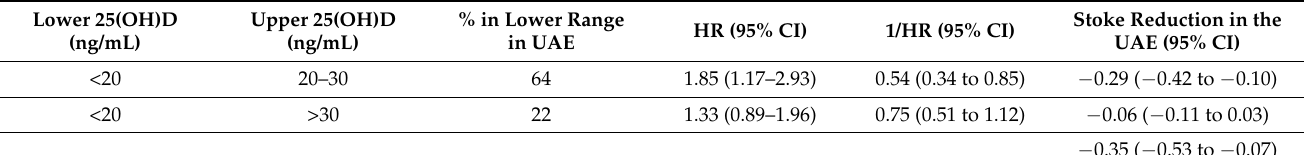
Table 4. Estimate of reduction in stroke incidence rate in the UAE by raising minimum 25(OH)D concentration to 30 ng/mL using 25(OH)D data from [85] and results from a U.S. study